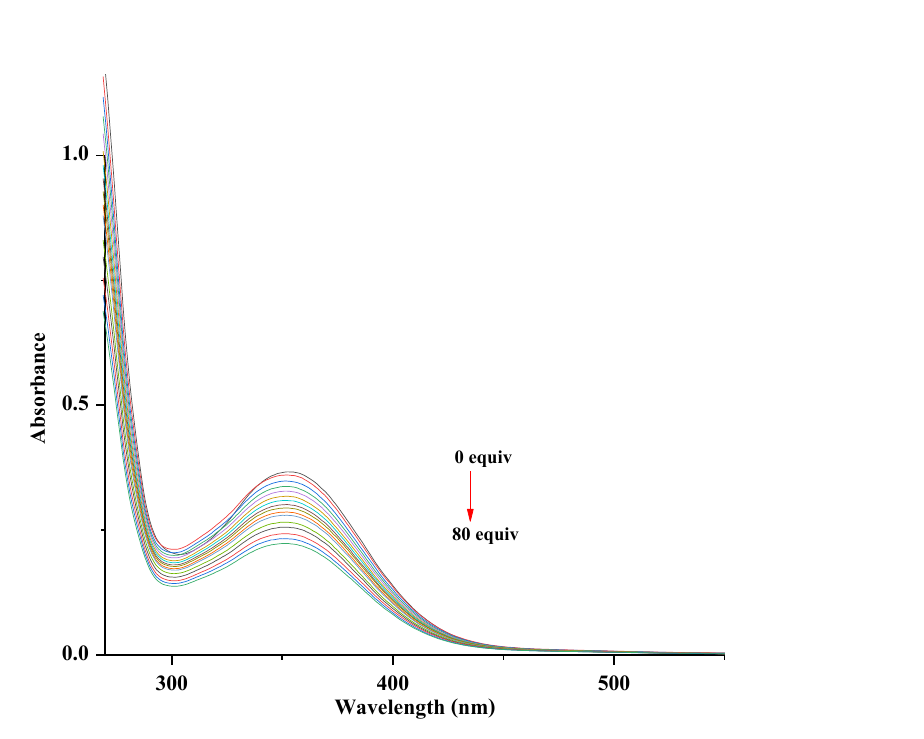
Figure 8. UV-vis spectra of titration between sensor R1 (1 × 10 − 4 M) and CH 3 COO – in a range of concentrations (0–80 equivalents) in DMSO.